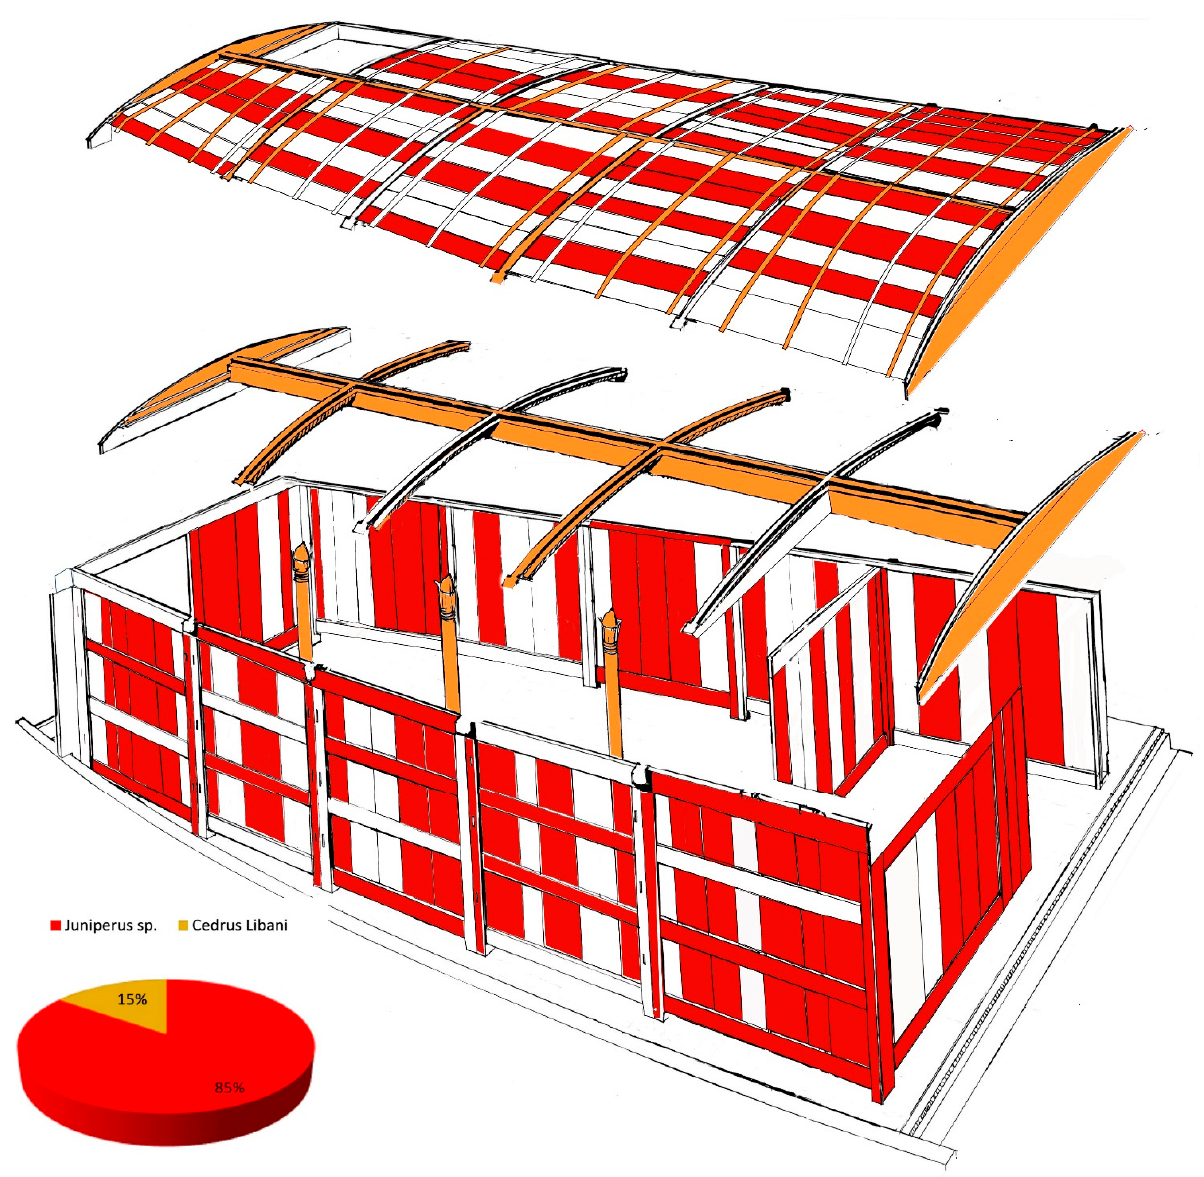
Figure 3. Rendering of the wood species used on the deckhouse as numbered in Table 1.